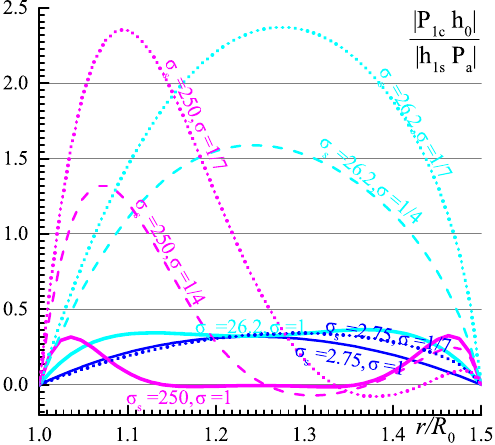
Figure 15. Distribution of P 1c inside of the 1D parallel ring with high-pressure